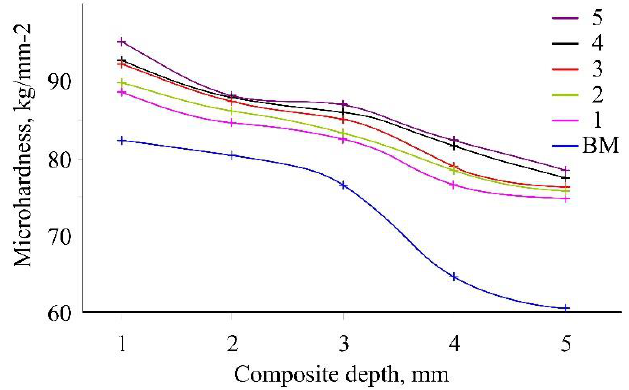
Figure 6. Microhardness at various depths for the cured compositions containing different amounts of the modifier. Numbers of lines correspond to the sample numbers.